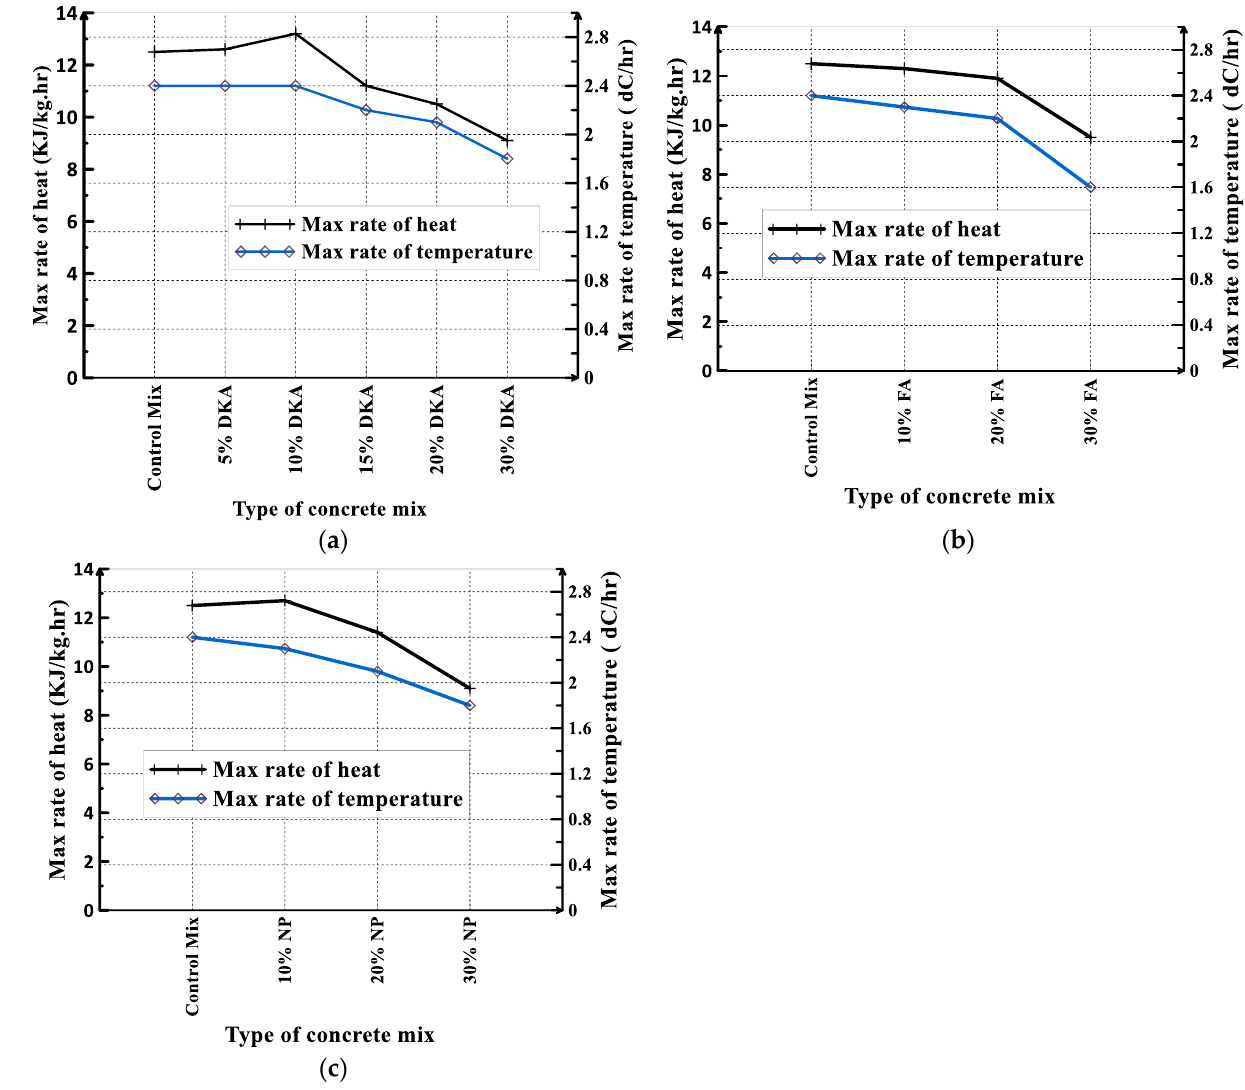
Figure 18. Rate of heat and temperature rise for concrete mixes containing ( a ) DKA, ( b ) FA, and ( c ) NP.